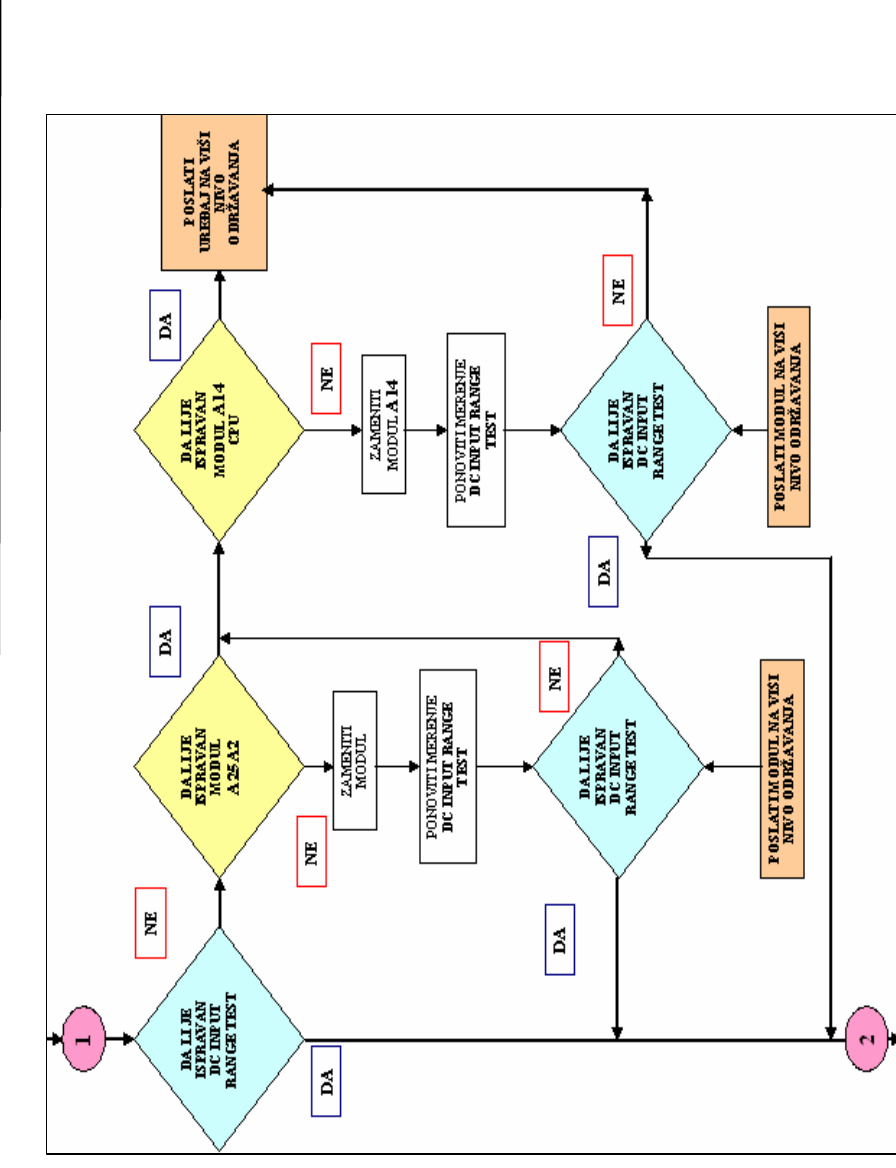
Рис .6 – Пример модели алгоритма для определения состояния